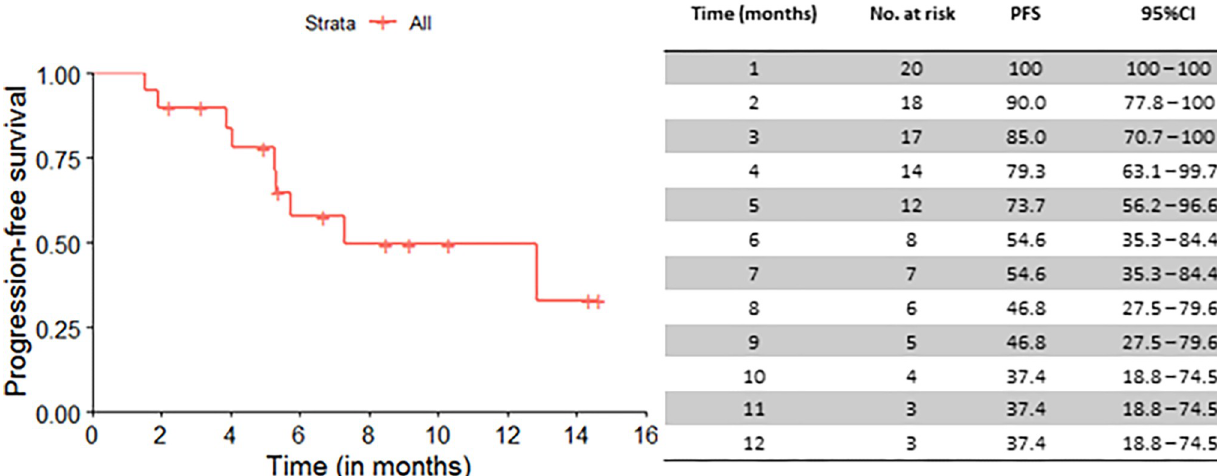
Fig 2. Progression-free survival curve for all patients (n = 20). Median PFS (months): 7.3 (95%CI: 5.3 to not reached).